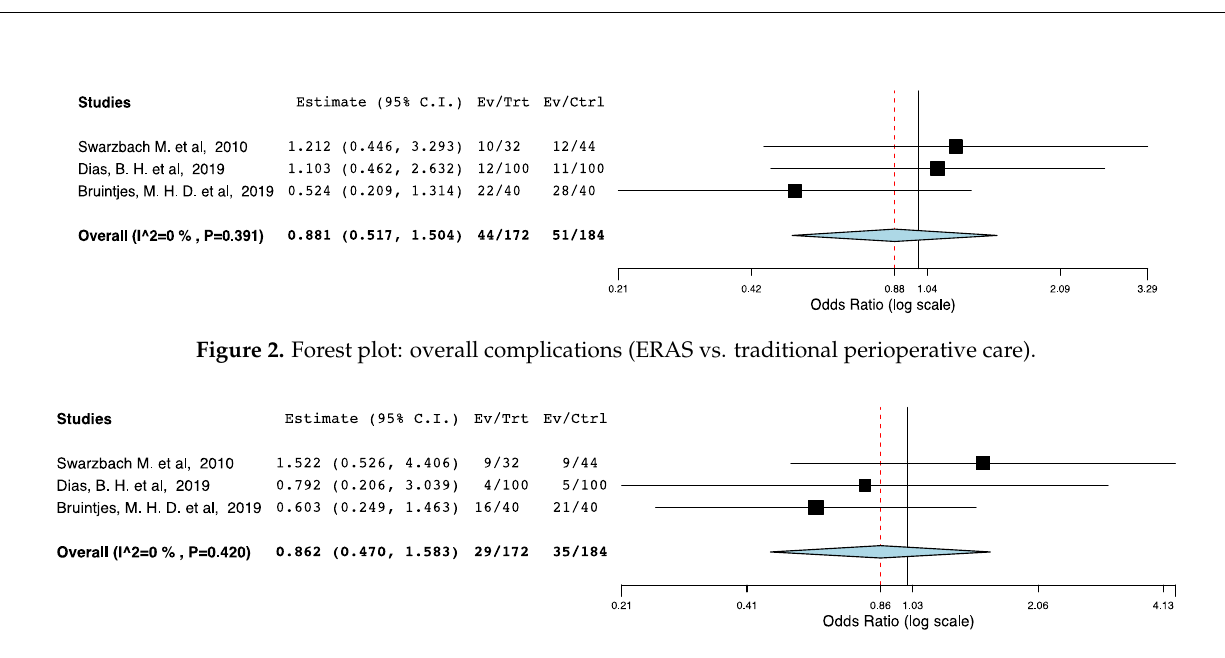
Figure 3. Forest plot: Clavien-Dindo I-II complications (ERAS vs. traditional perioperative care).